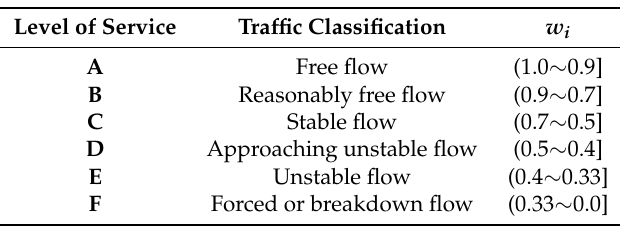
Table 5. Level of service and traffic classification